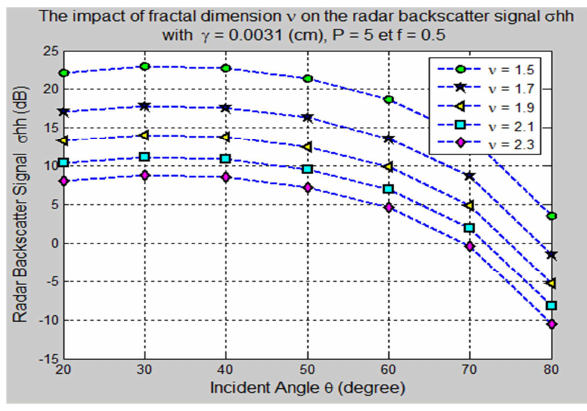
Figure 7. Backscattering coefficient dependence on fractal parameter ν at HH polarization